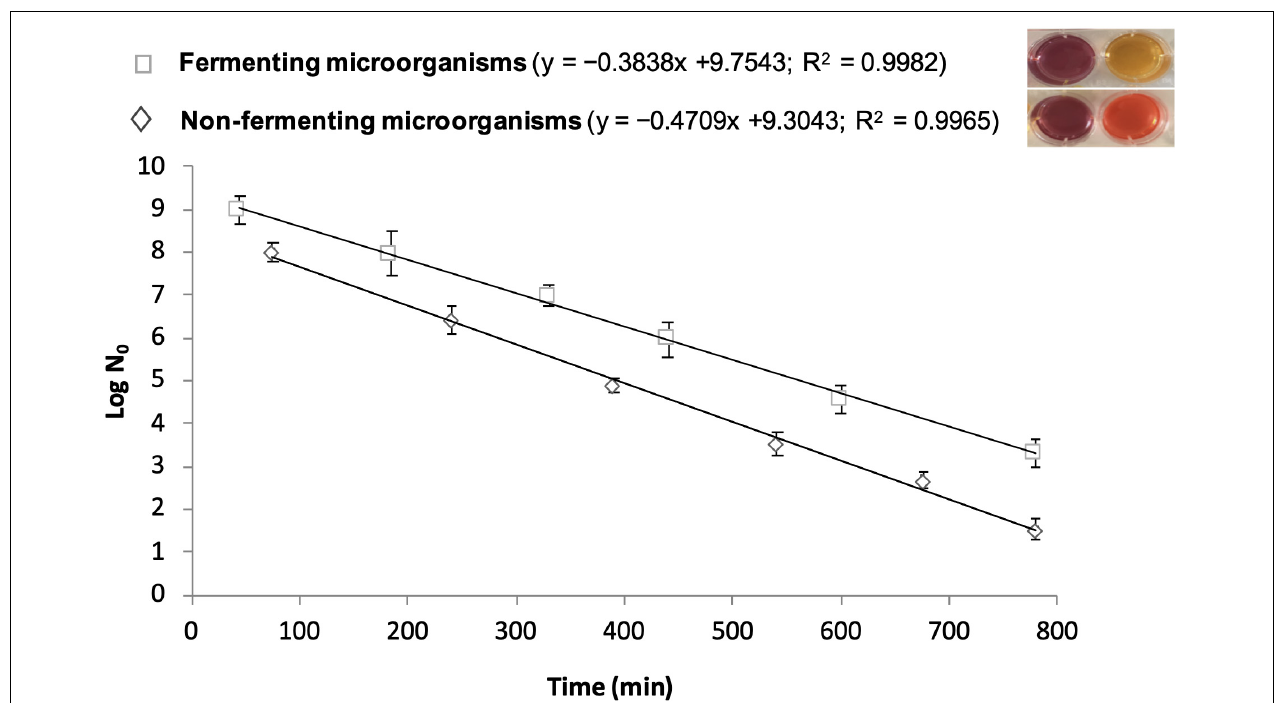
FIGURE 2 | Correlation lines obtained by BioTimer Assay with the reagent containing both Phenol Red and Resazurin as indicators in order to enumerate fermenting (color switch from violet-to-yellow) and non-fermenting (color switch from violet-to-orange) microorganisms. The correlation lines show the relationship between the time ( X -axis) required for color switch and the initial number of microorganisms ( Y -axis). The equations and the linear correlation coefficients describing the correlation lines for both fermenting and non-fermenting microorganisms are reported in